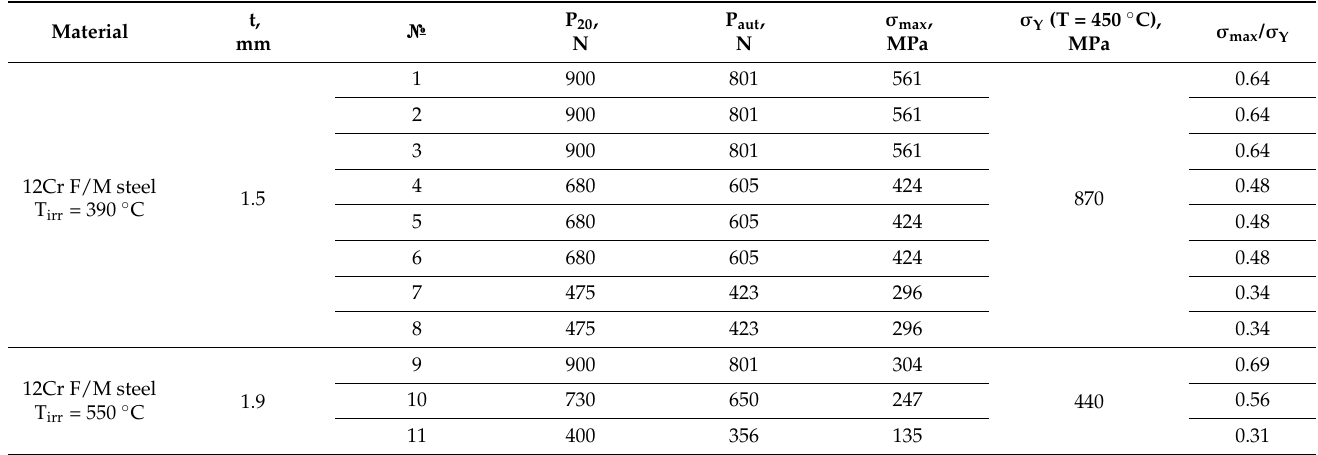
Table 4. The values P 20, P aut , σ max , σ y , σ max / σ y and t values for 12Cr F/M steel.